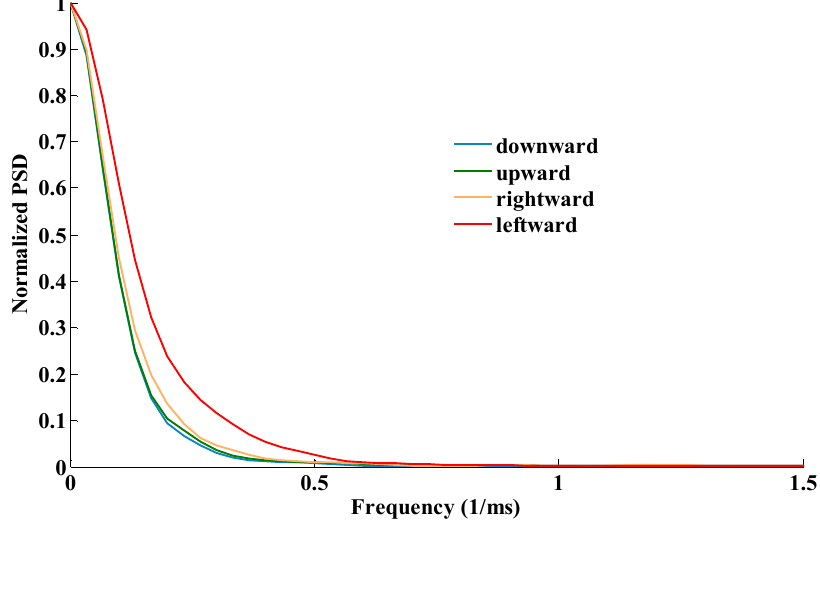
Figure 4. The PSD (power spectral density) of